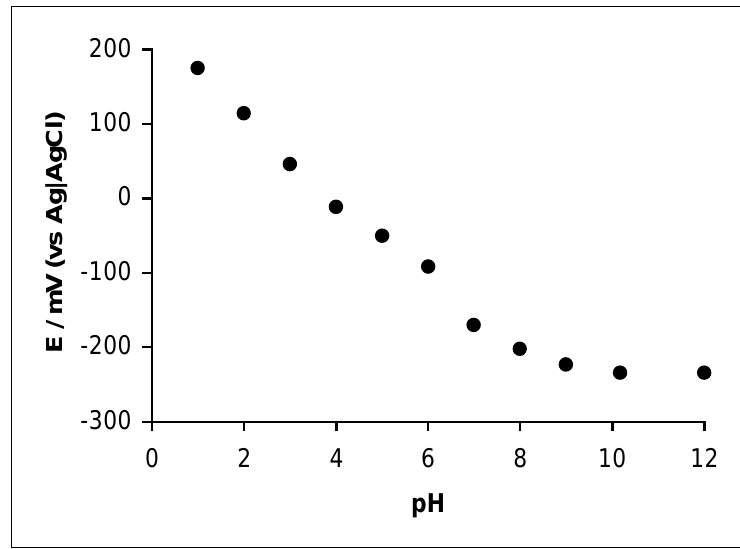
Figure 2: The CV reponse of the GCE-CoPc-(CoTPP)